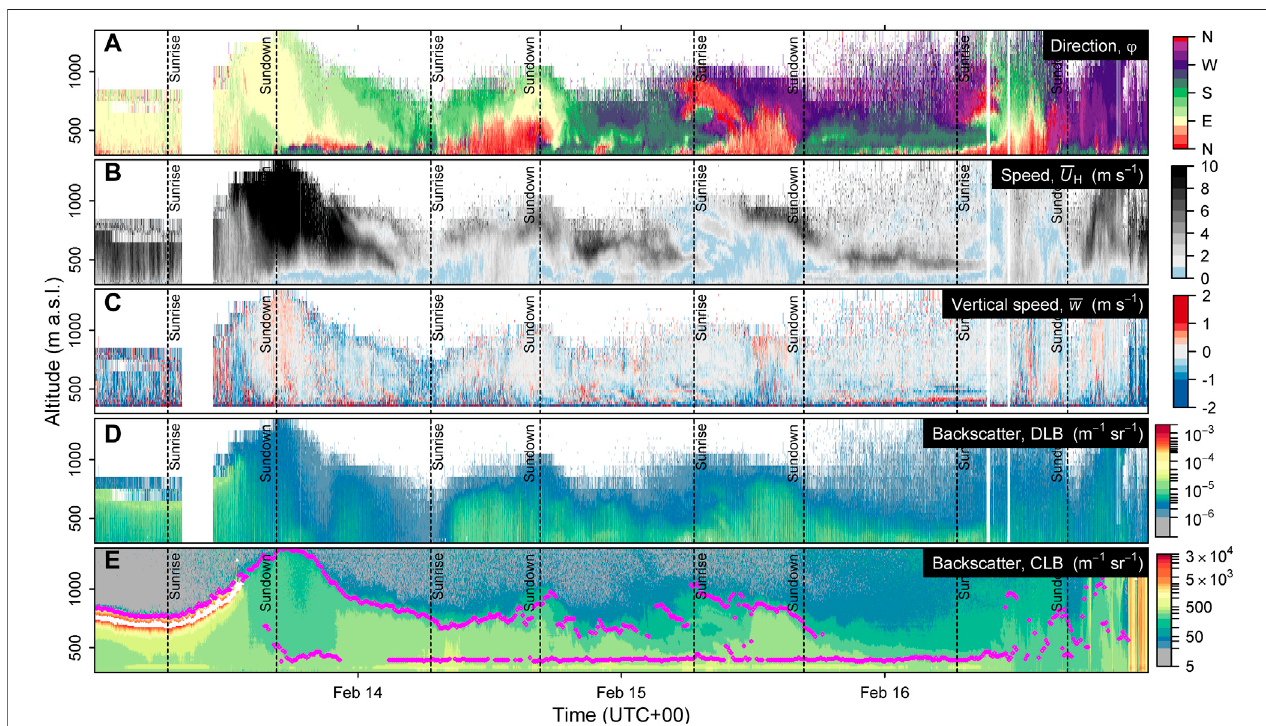
FIGURE9| Verticalpro fi lesof (A) winddirection( φ ), (B) horizontalwindspeed ( (cid:1) U H ) , (C) verticalwindspeed ( (cid:1) w ) , (D) Dopplerlidarbackscatter(DLB)signaland (E) theceilometerbackscatter(CLB)signalareshownforStuttgart CityCentreduringtheperiod 13February2017to16February2017.Theceilometer-derivedcloudbase height and mixing layer height are shown in (E) as white triangles and magenta diamonds,